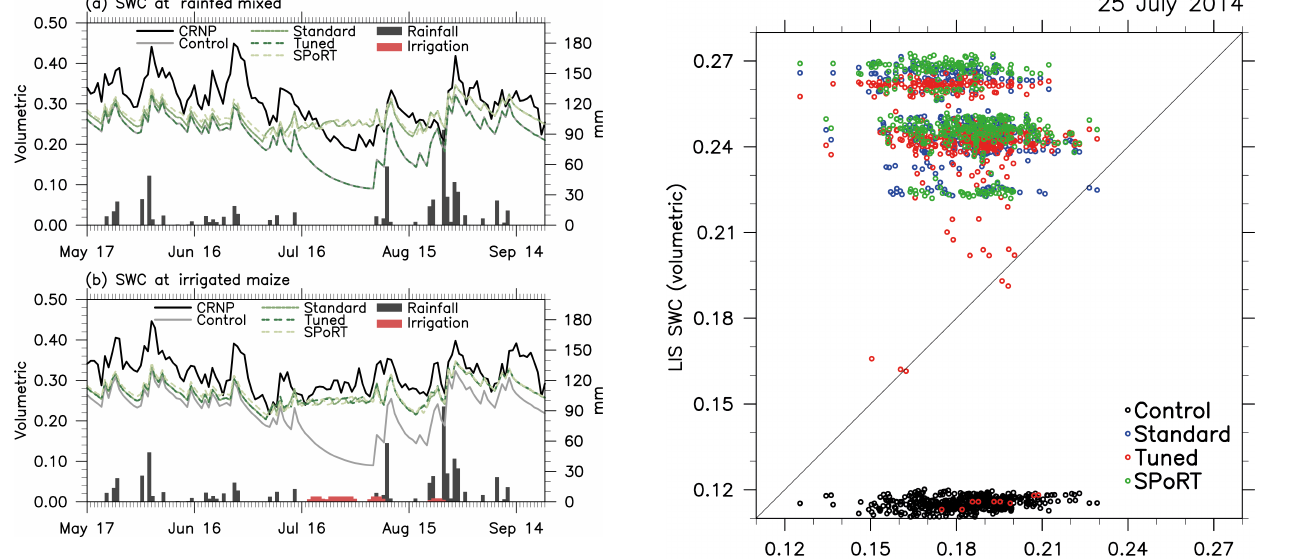
Figure 7. Volumetric soil water content (left axis) at the rain-fed (a) and irrigated maize (b) sites. The black solid line shows obser- vations from the CRNP probe; the gray and green lines show the LIS Control and irrigation simulations, respectively. Dark gray bars show accumulated daily precipitation from the Automated Daily Weather Network in York, Nebraska, and pink bars show the accu- mulated irrigation amount at the irrigated maize and soybean sites (right axis).